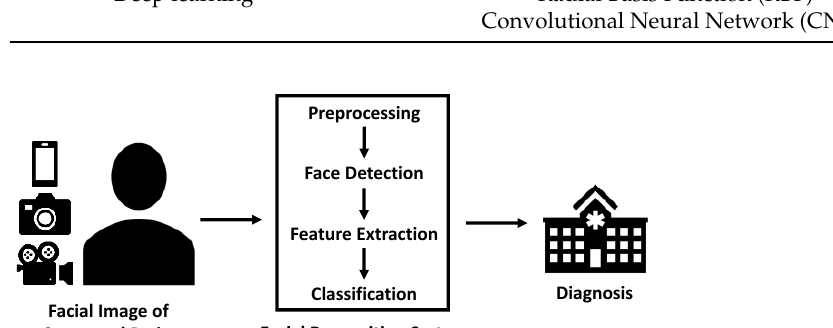
Figure 1. Workflow of facial recognition in disease diagnosis.